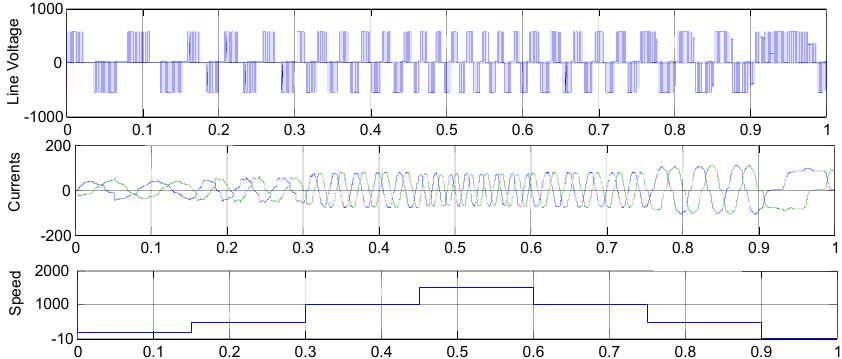
Figure 6. Effect of speed variation (decrement/increment) on voltage and current using the main battery.